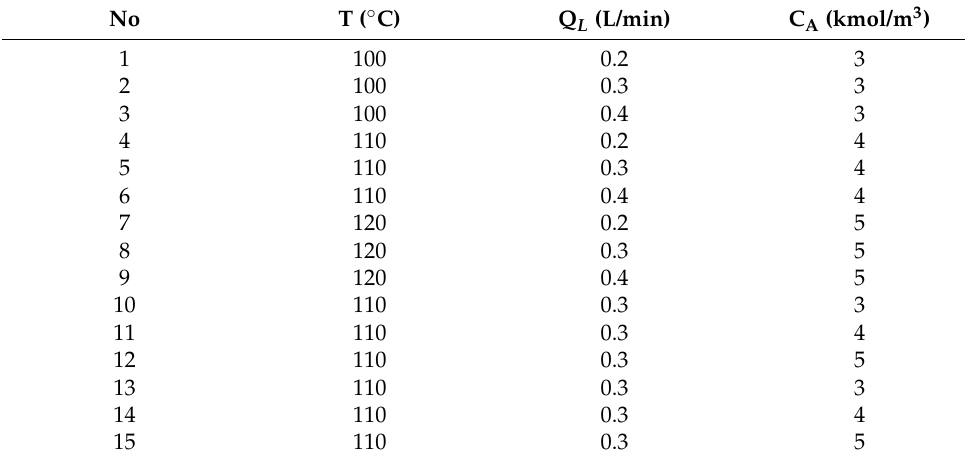
Table 1. Operating conditions conducted in this